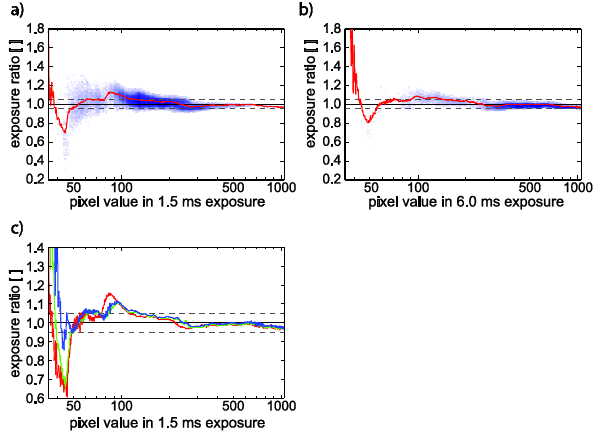
Figure 7. Evaluation of sensor linearity using sky images under thin Fig. 7. Evaluation of sensor linearity using sky images under thin overcast conditions. 3 overcast conditions. In (a) , a point cloud (and median in red) show- In (a), a point cloud (and median in red) showing the distribution of the ratio between 4 ing the distribution of the ratio between a 6ms exposure and a mod- a 6 ms exposure and a modeled 6 ms exposure generated from a 1.5 ms exposure, 5 eled 6ms exposure generated from a 1.5ms exposure, as a function as a function of measured value in the 1.5 ms image. In (b), the same as (a), but with 6 of measured value in the 1.5ms image. In (b) , the same as (a) , but 6 ms and 24 ms exposures. In (c) the median line for each color is shown. To reduce 7 with 6 and 24ms exposures. In (c) the median line for each color is random noise, each of the compared images is the average of five exposures 8 shown. To reduce random noise, each of the compared images is the captured over the course of approximately 3 seconds. 9 average of five exposures captured over the course of approximately